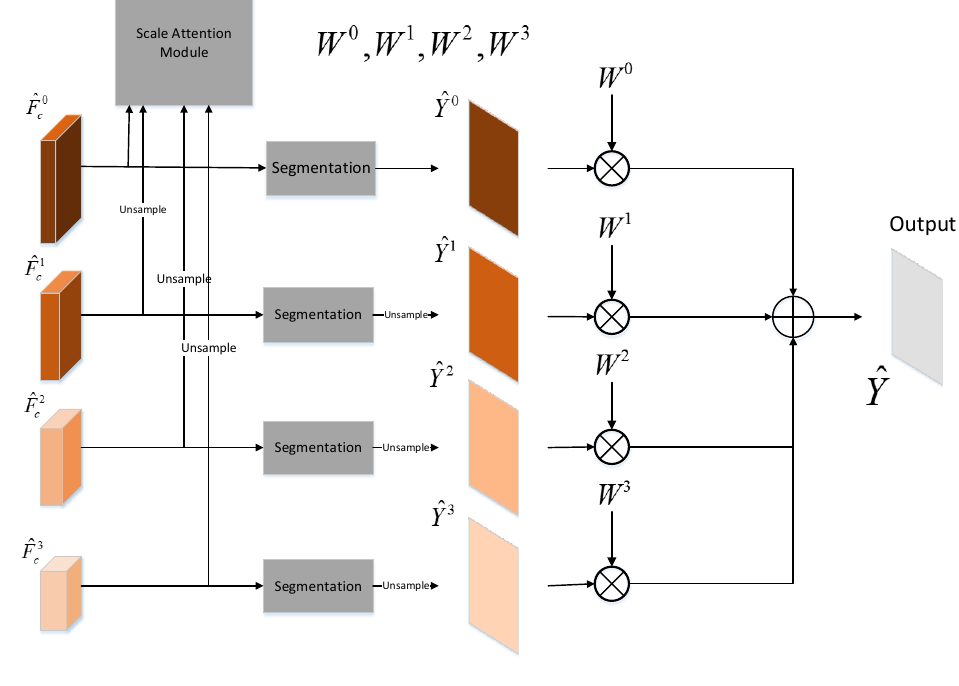
Figure 5. Multiscale Fusion Module.